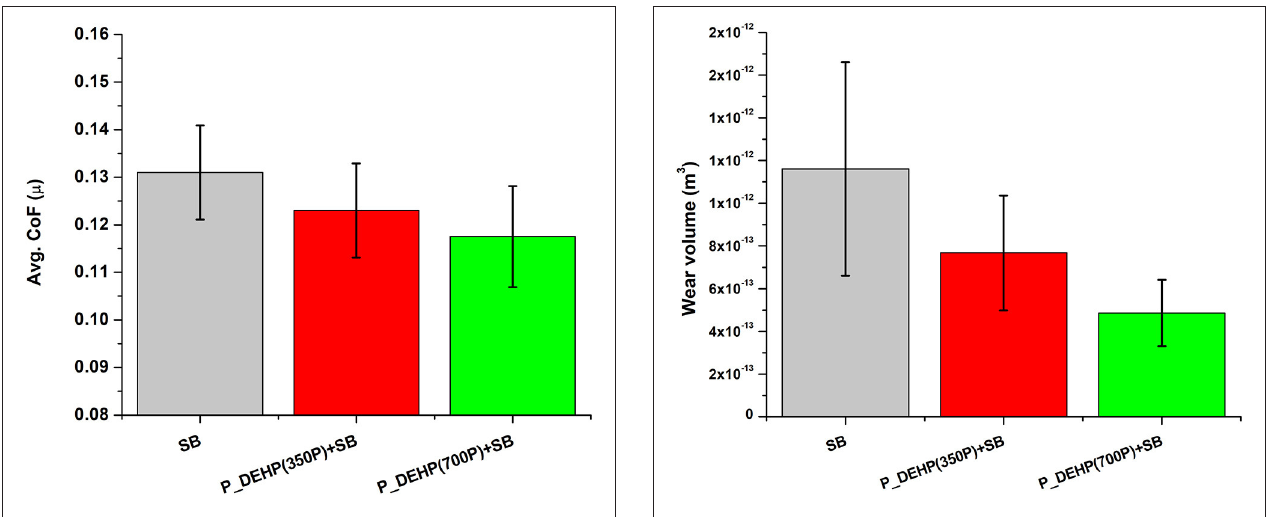
profile at the center of the cylinders and 3D images of the area of contact on the cylinders after tribological tests. The cylinder surface for SB reveals severe wear as the 2D profile is virtually flat at the center. The improved wear protection with the additive mixture of borate ester, SB, and P_DEHP ionic liquid at 700 ppm of P is visually evident in the 3D profilometry images.